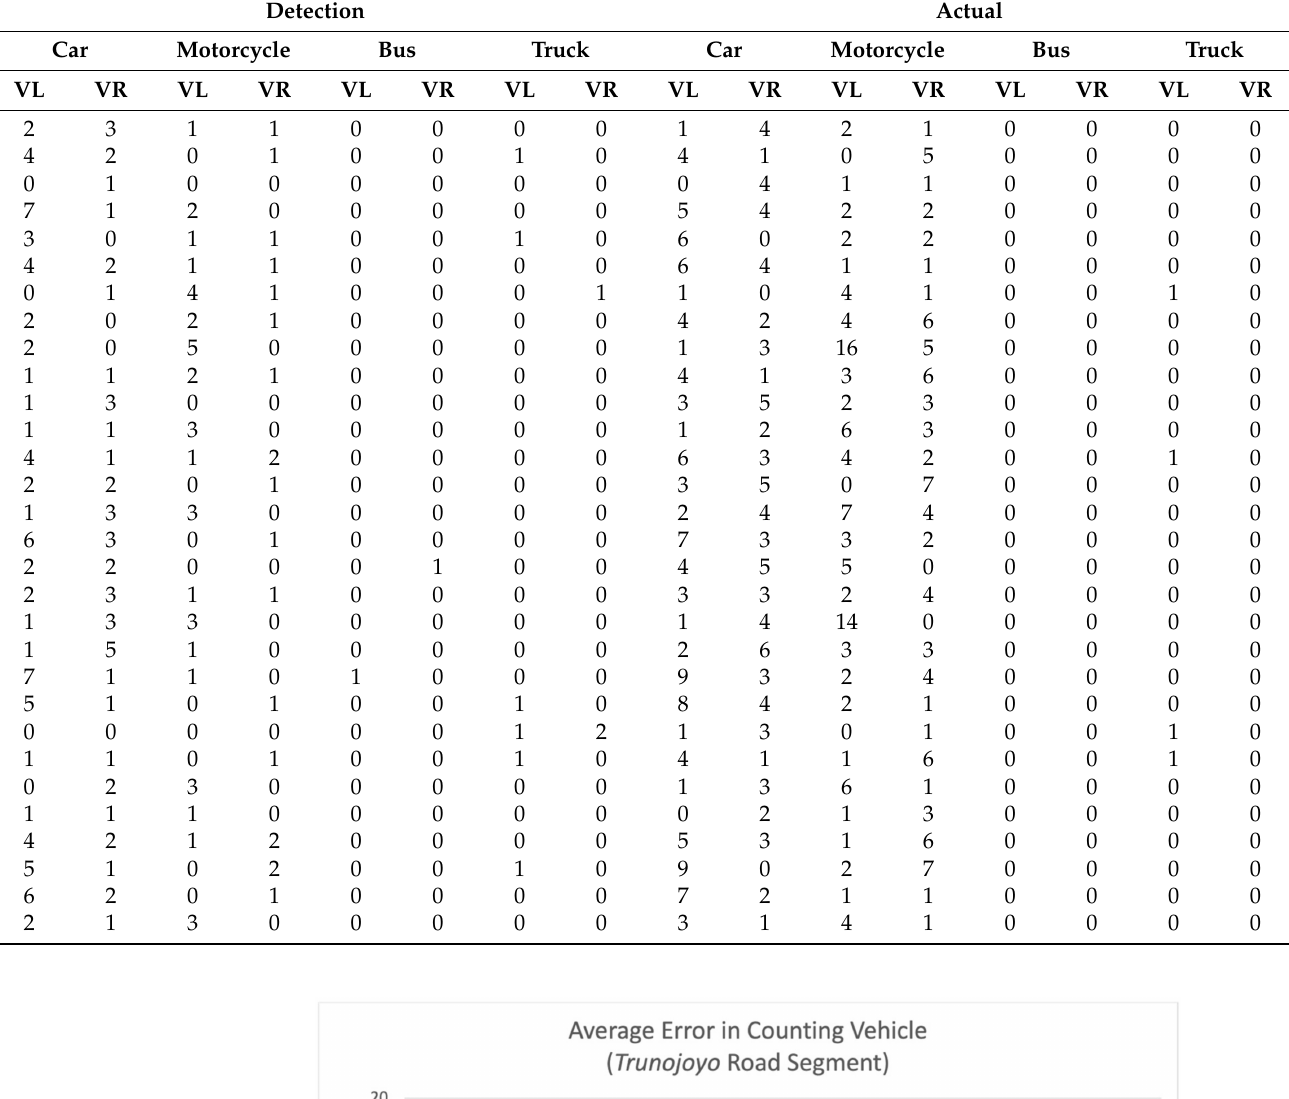
Table 10. Comparison between detection and actual result on Trunojoyo road segment.